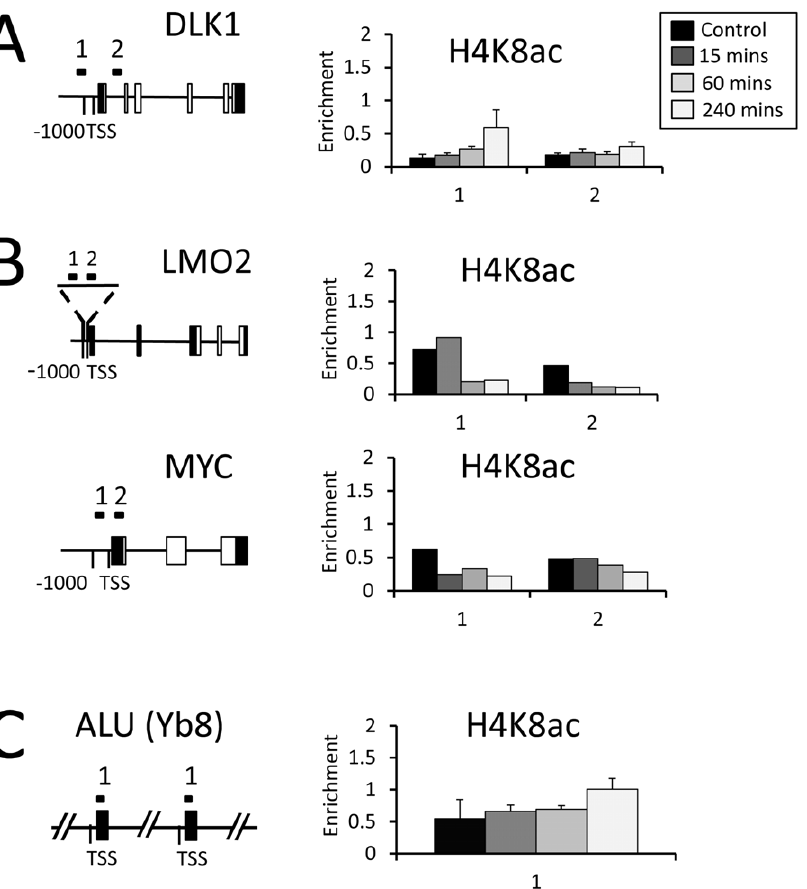
Figure 5. Histone acetylation changes on up- and down-regulated genes during extended VPA treatment. Chromatin- immunoprecipitation analysis of H4K8ac on: ( A ), Up-regulated gene ( DLK1 ), ( B ), Down-regulated genes ( LMO2, MYC ) or ( C ), repetitive elements ( ALU ) in response to VPA treatment (5 mM). Analysis was performed on either untreated cells (Control), or during VPA treatment (15, 60 & 240 minutes). Primer locations are indicated on the gene diagrams. The abundance of a histone modification (‘ Enrichment ’) is calculated from the ratio of material detected in bound:unbound fractions.